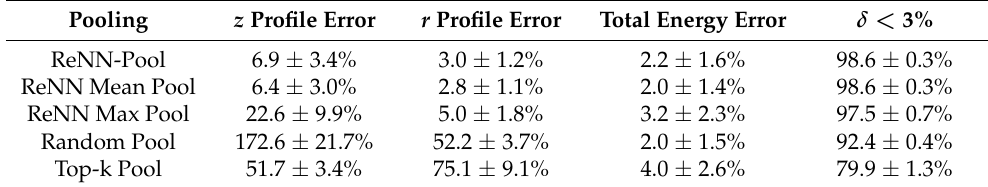
Table 2. Results of ablation study on pooling . Comparison of the results on the test set of the Water + Slab dataset using different pooling and un-pooling techniques. Mean relative errors on energy profiles and total energy along with the mean 3% δ -index passing rate on test sets are reported. Pooling z Profile Error r Profile Error Total Energy Error δ < 3% ReNN-Pool 6.9 ± 3.4% ReNN Mean Pool ReNN Max